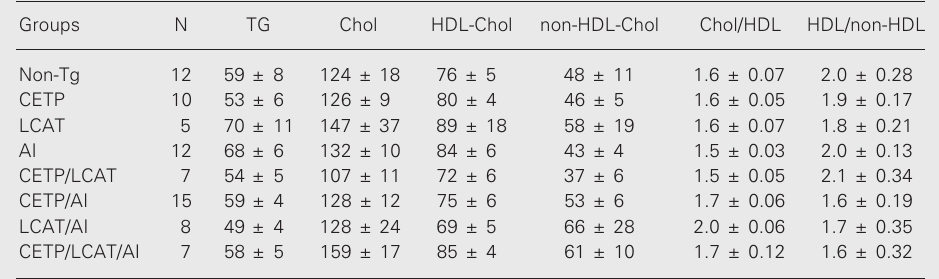
Table 1. Plasma lipid and lipoprotein concentrations in mice expressing combinations of apo AI, LCAT and CETP transgenes after 4 months on a high fat, high cholesterol cholate-containing diet.